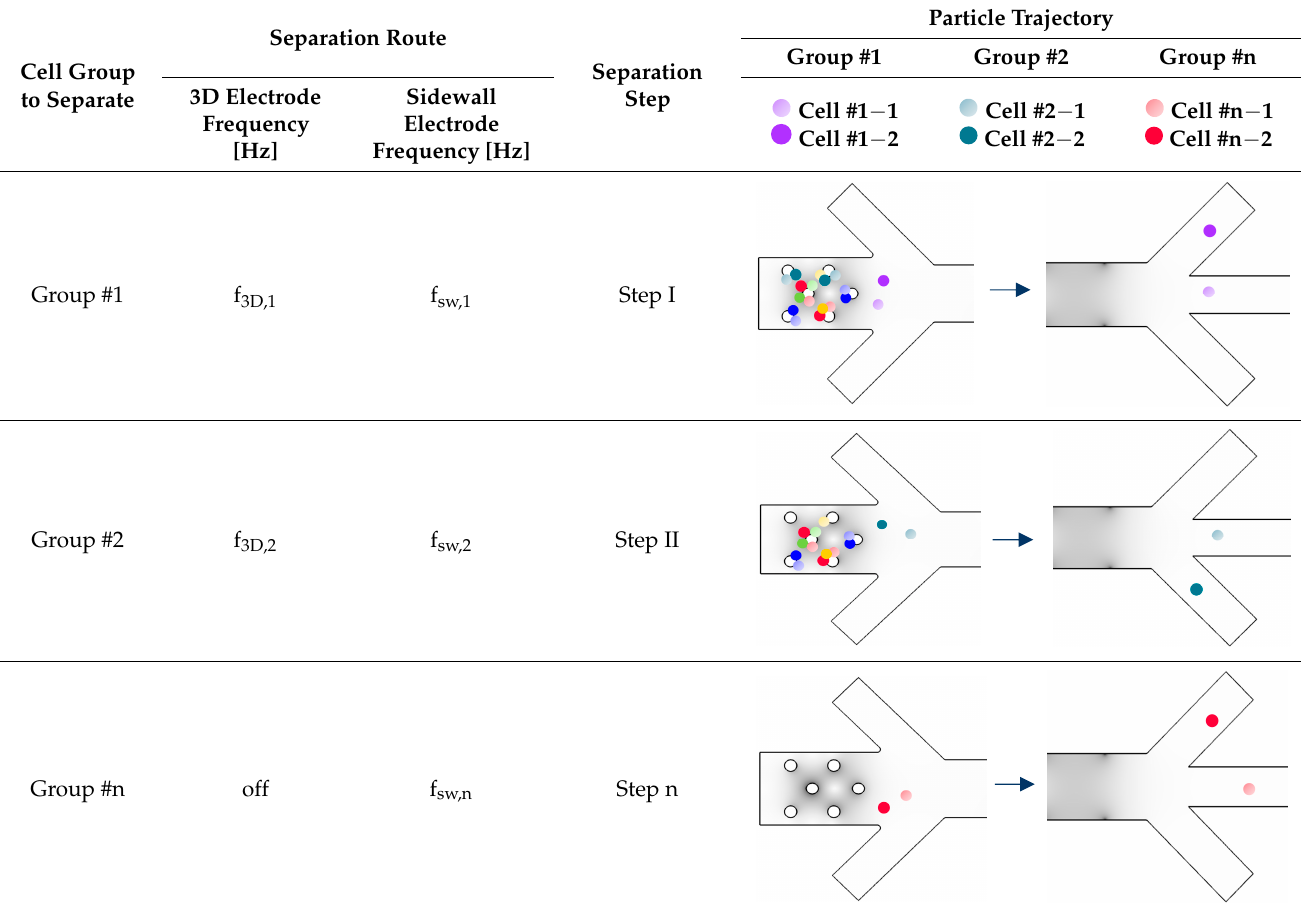
Table 3. The working principle of the proposed microfluidic device.